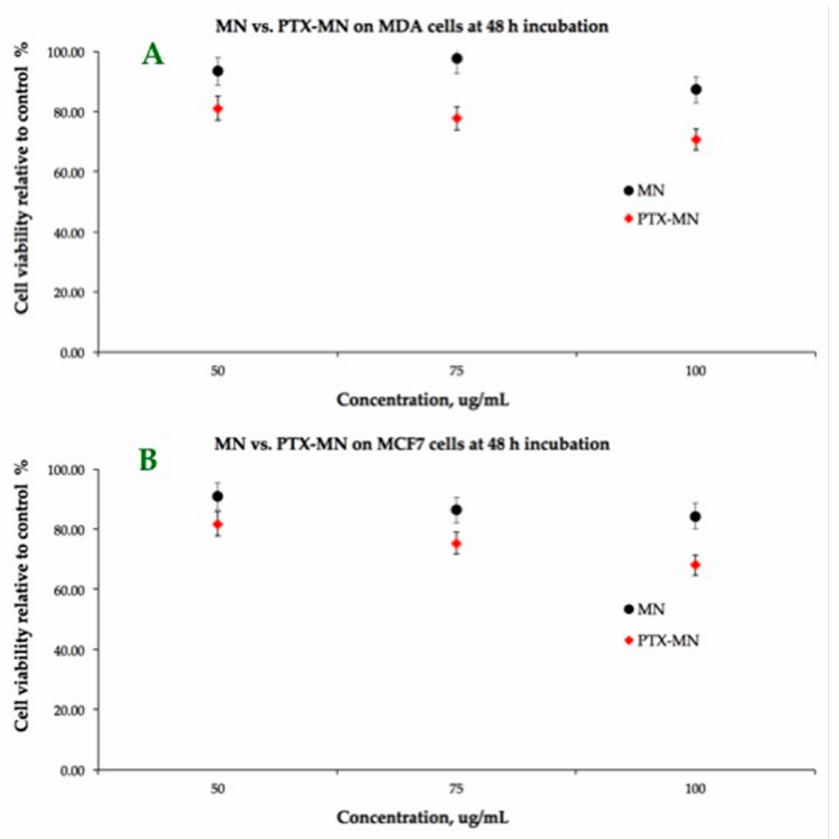
Figure 10. Cellular viability-MTT assay on MCF-7 and MDA-MB-231 cell lines of MN ( A ) and PTX-MN nanoparticles ( B